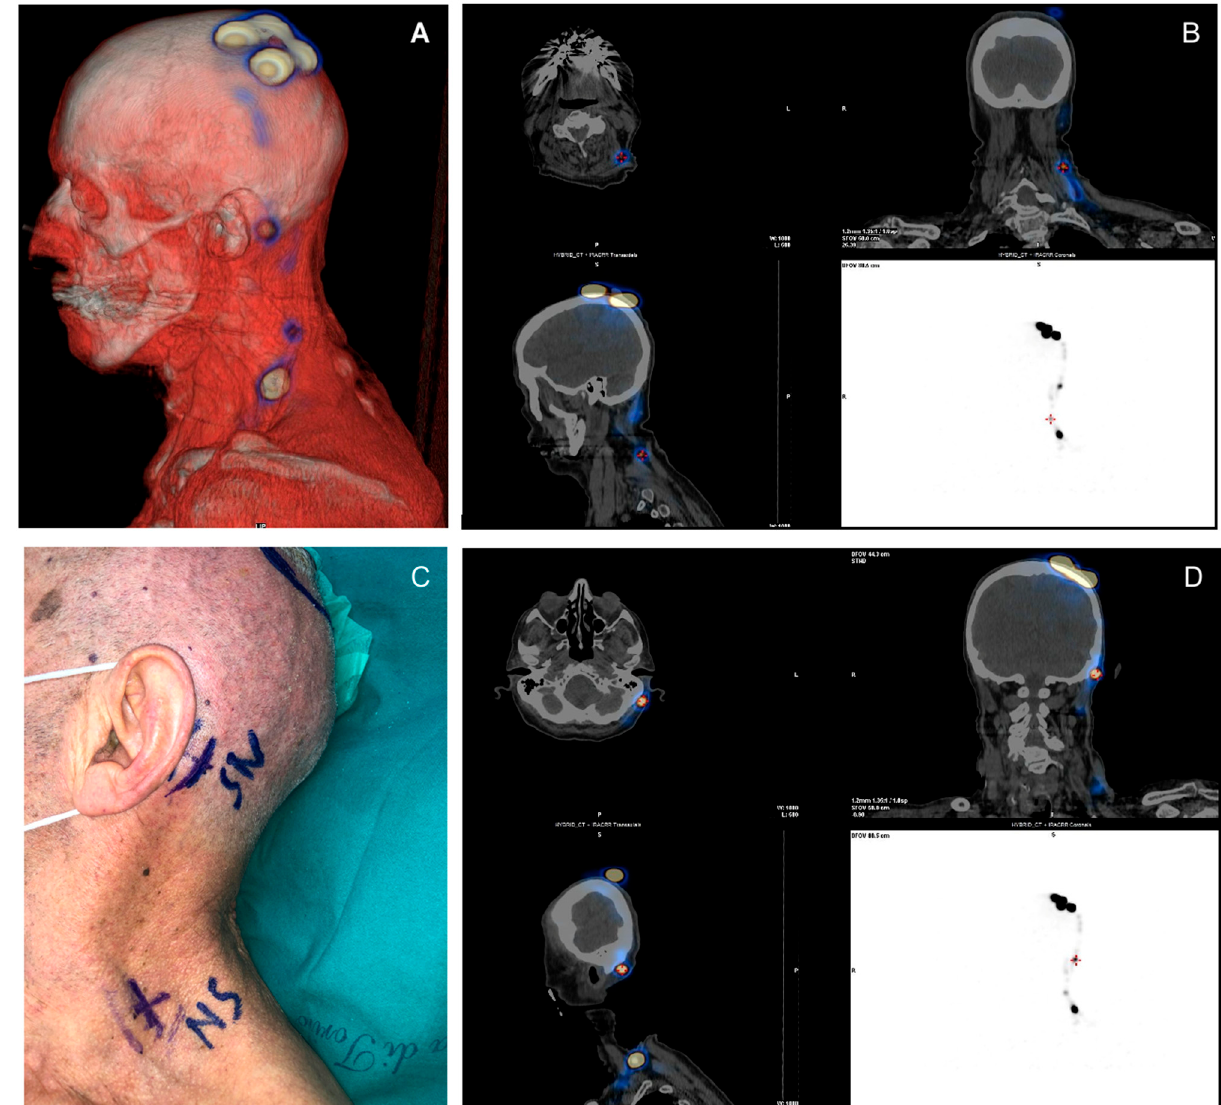
Figure 1. (Case 1): ( A ) A 3D image of the left retroauricular sentinel lymph node. ( B – D ) SPECT/CT rendering with a view of lymph nodes in CT reconstruction. ( C ) Preoperative image with skin marking of lymph nodes. SPECT-CT: single-photon emission computed tomography—computed tomography